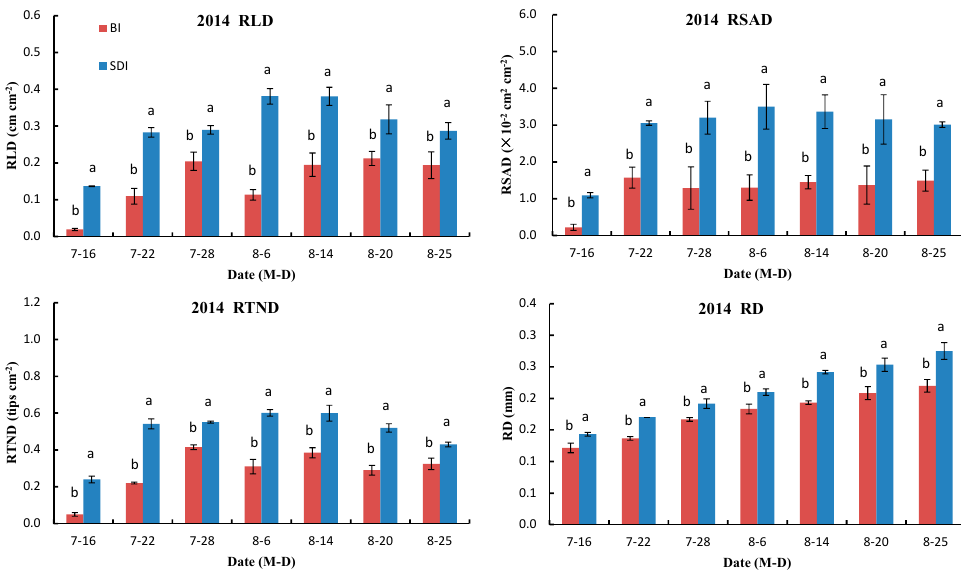
Figure 8. Variations in the RLD, RSAD, RTND and RD of transplanted cotton in 2014. Abbreviations: BI, border irrigation; SDI, surface drip irrigation; RLD, root length density; RSAD, root surface area density; RTND, root tip number density; and RD, root diameter. The vertical bars represent the standard errors of the means. Different lowercase letters indicate significant differences ( p < 5%) between the two treatments.